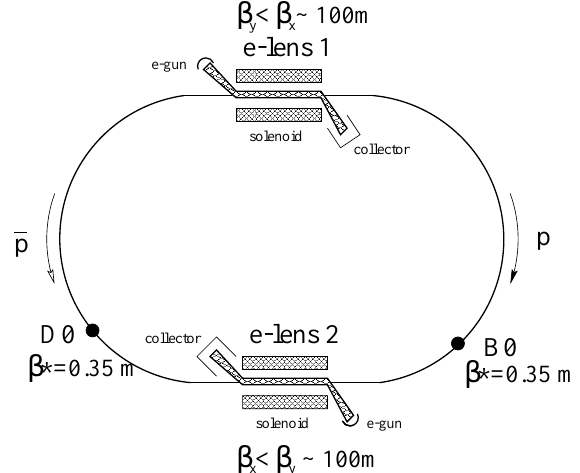
FIG. 3. Schematic Tevatron layout with two electron lenses.